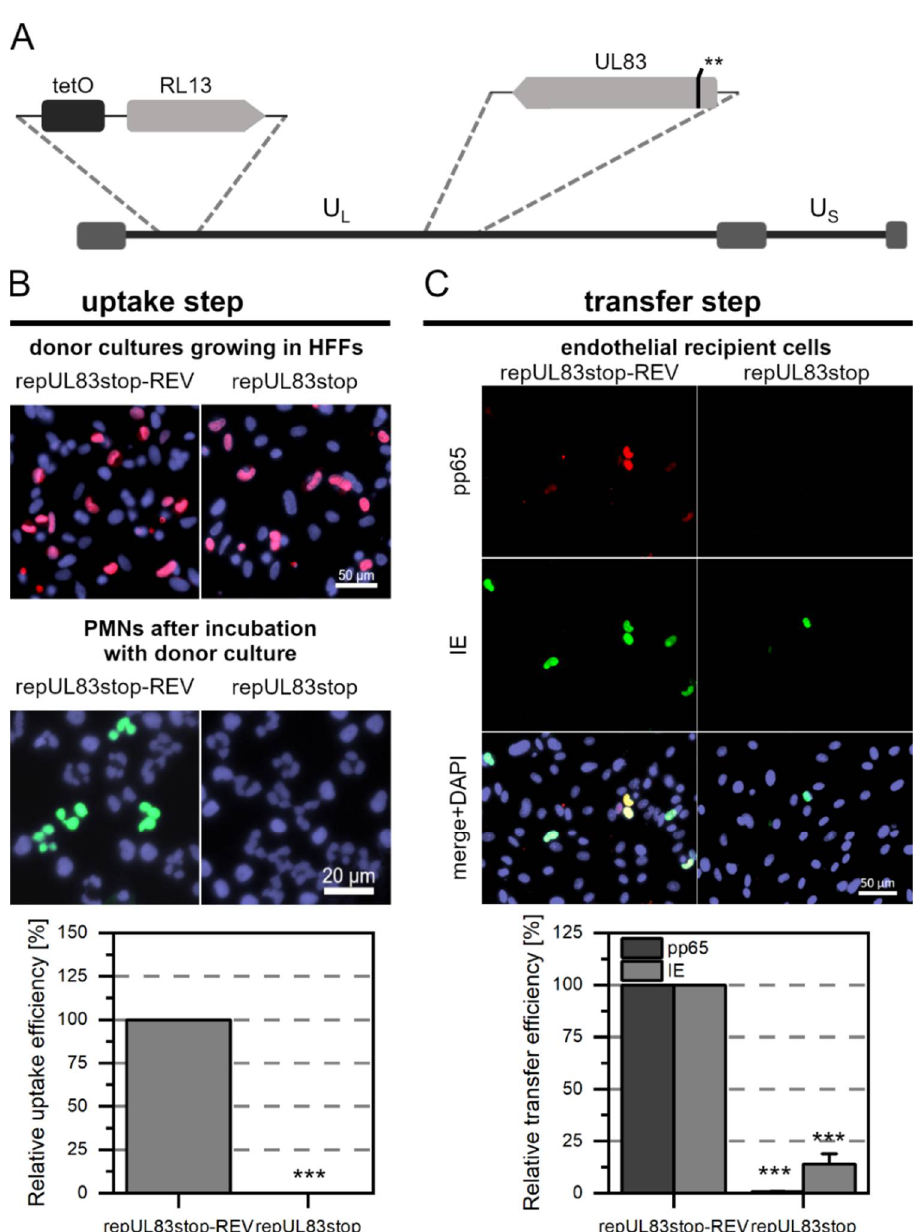
Figure 4. The tegument protein pp65 of HCMV is required for PMN-mediated transfer to endothelial cells. ( A ) Genomic overview of the generated Merlin mutant representing the unique long (U L ) and short (U S ) sections: the mutant carries the tet operator upstream of RL13. In comparison to the wild-type, two consecutive stop codons (**) were introduced into the ORF of UL83 as indicated. ( B ) Characterization of the uptake step to PMNs. PMNs were isolated from EDTA blood of HCMV-seronegative donors and incubated for 3 h at 37 °C with repMerlin-RL13tetO-UL83stop or its revertant repMerlin-RL13tetO-UL83stop-REV. PMNs were recollected, and a fraction was used for the preparation of cytospots. Donor cultures were fixed and stained via indirect immunofluorescence for viral IE Ag (pink nuclei). PMNs were fixed and stained for viral pp65 (green nuclei). Nuclei were counterstained with DAPI (purple nuclei). The uptake efficiency was calculated as the fraction of pp65-positive PMNs compared to all PMNs and is shown relative